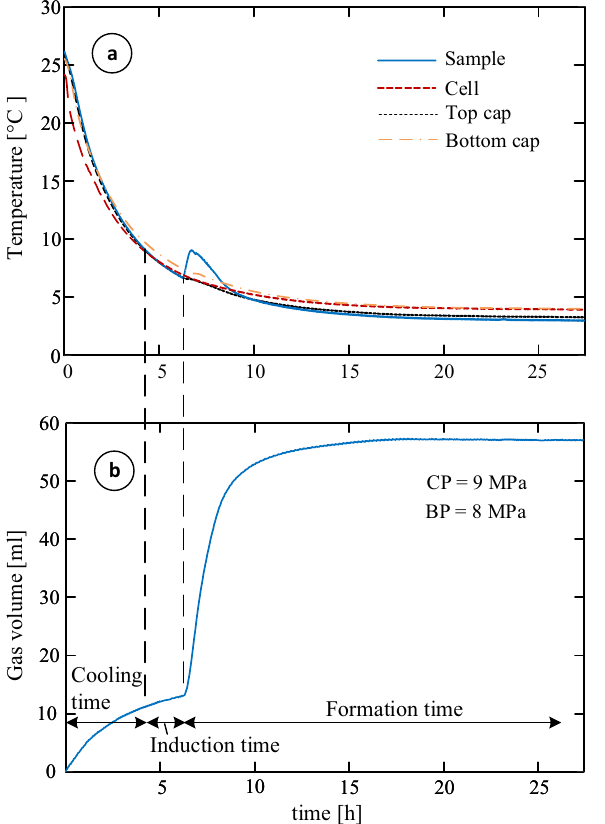
Figure 2. ( a ) Temperatures measured by the four thermometers in the system and ( b ) the gas consumption during the hydrate formation process.